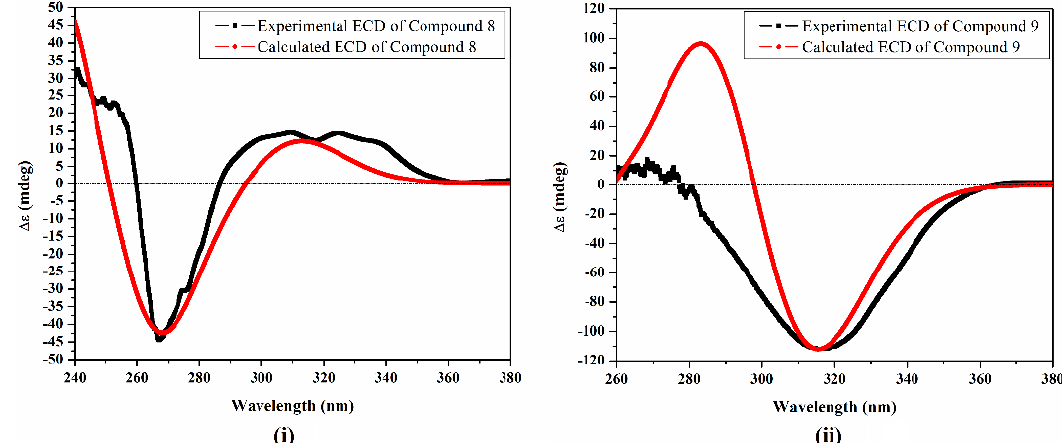
Figure 4. Experimental and theoretical ECD spectra for compounds 8 ( i ) and 9 ( ii ).